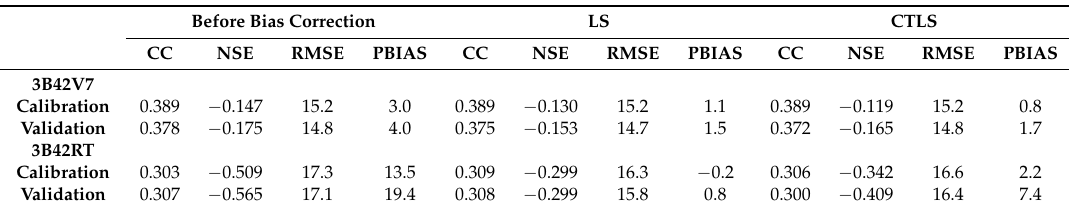
Table 9. The average performance of calibration and validation for climatology–topography-based linear-scaling approach (CTLS) with TMPA 34B42V7 and TMPA 3B42RT on a daily